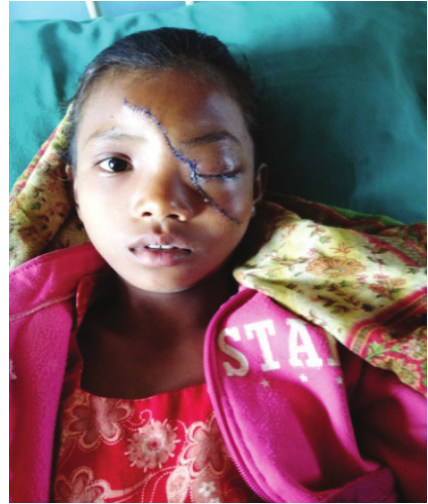
Figure 2: Injury due to the blade with linear fracture of frontal bone and injury to the globe.